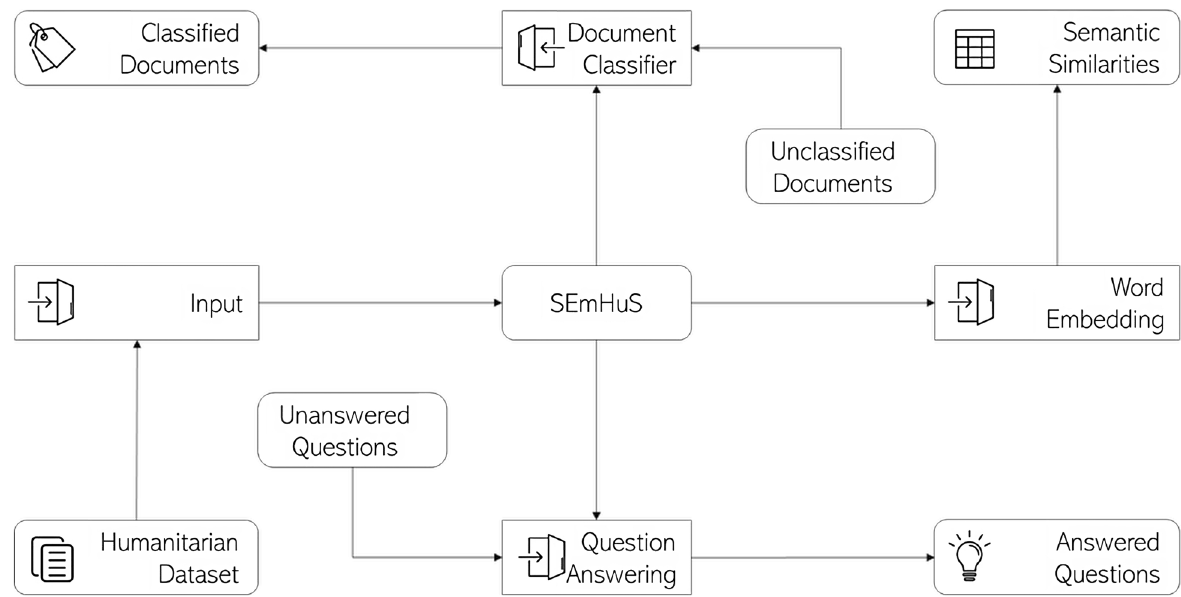
Fig. 5 Model potential